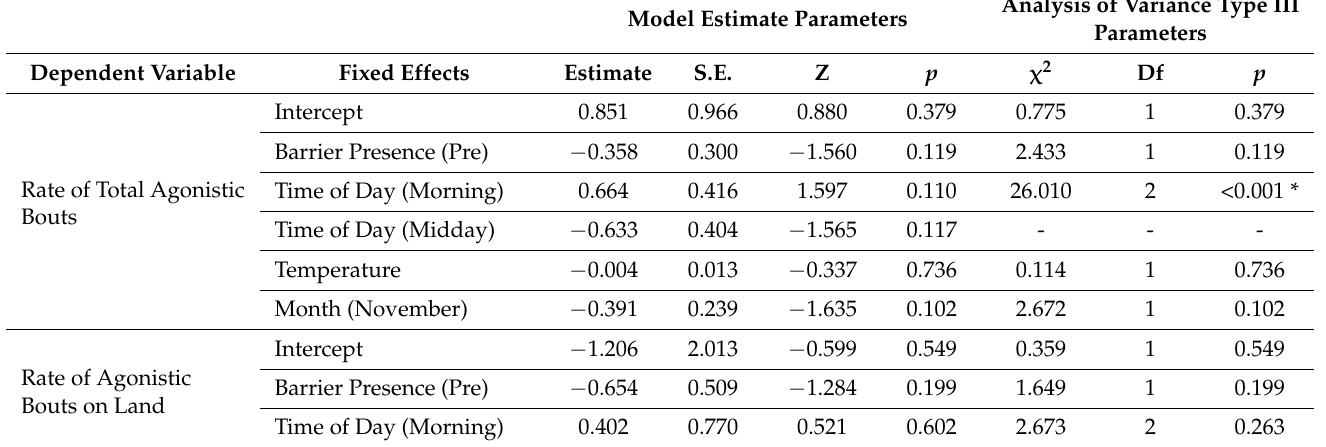
Table A2. Statistical outputs for models of the long-term monitoring